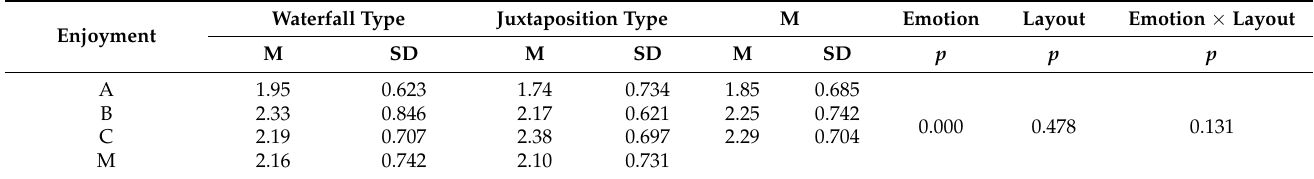
Table 8. Descriptive statistics and two-way ANOVA for the enjoyment of the